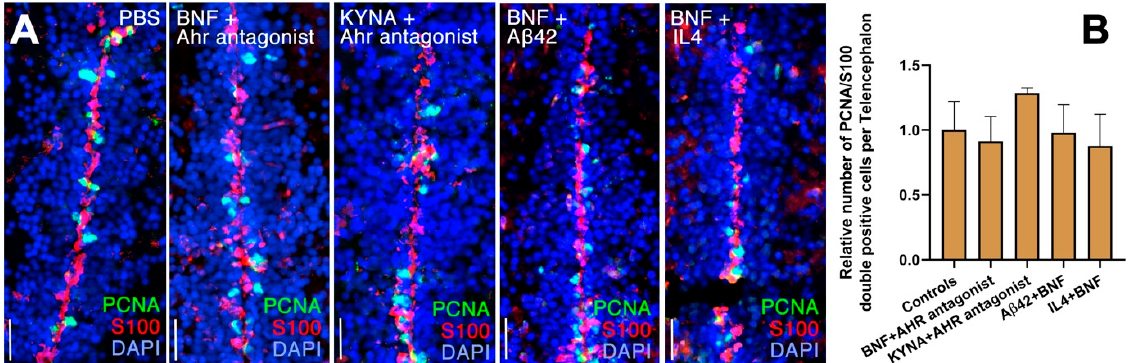
Figure 4. Ahr2-dependent suppression of neural stem cell plasticity is antagonized by neuroregenerative factors in adult zebrafish brain. ( A ) Immunohistochemical stains for S100 β (red) and PCNA (green) in control (PBS), BNF+Ahr antagonist, KYNA+Ahr antagonist, BNF+A β 42 and BNF+IL4 injected brains. ( B ) Quantification of relative numbers of proliferating glial cells in conditions in A. Scale bars equal 50 μ m. Statistical calculations and values are provided in Table S1.